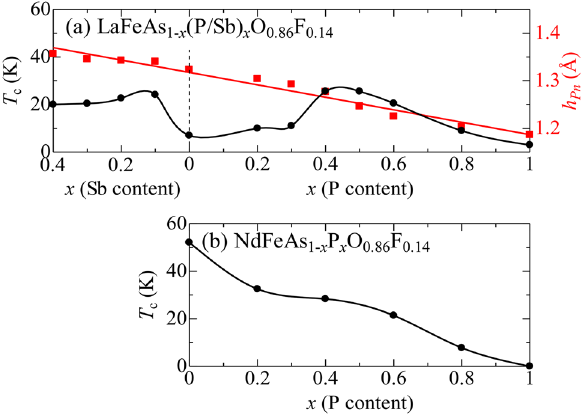
Figure 4. P(Sb) concentration x -dependence of T c (black circles) for ( a ) LaFeAs 1 − x (P/Sb) x O 0.86 F 0.14 and ( b ) NdFeAs 1 − x P x O 0.86 F 0.14 . The x -dependence of h Pn (red squares) for LaFeAs 1 − x (P/Sb) x O 0.86 F 0.14 is also shown in the ( a ). Solid lines are visual